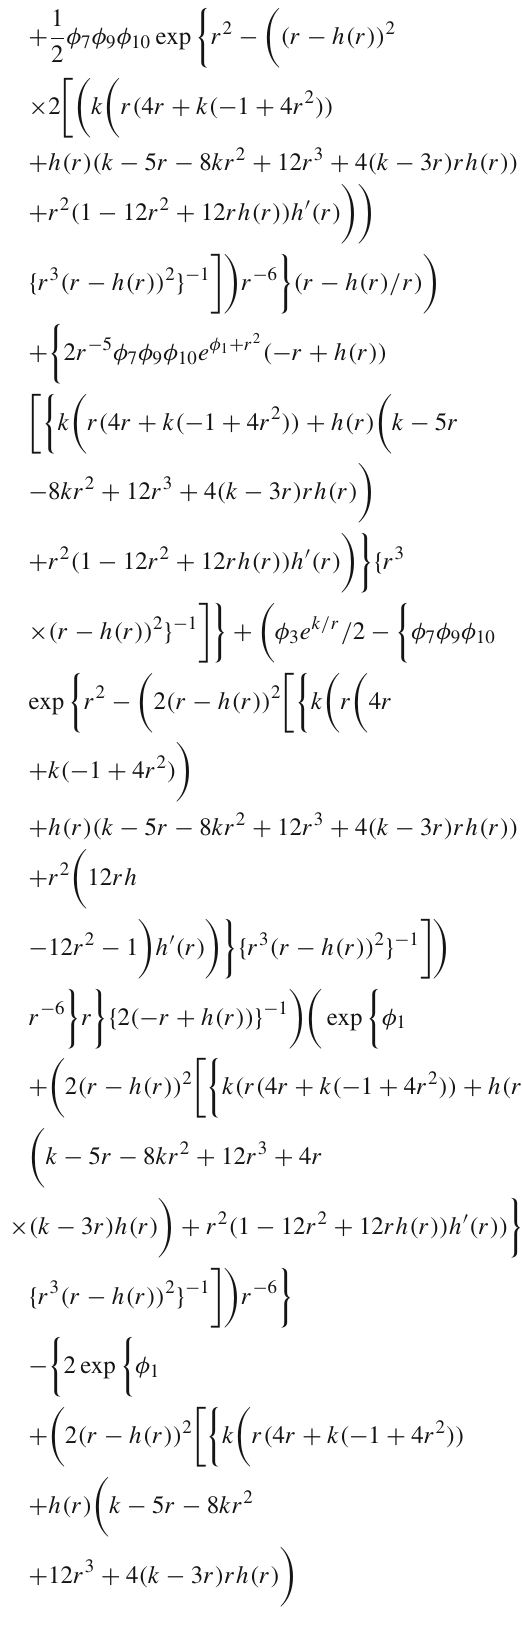
Fig. 8 Evolution of effective NEC versus r for w = − 1